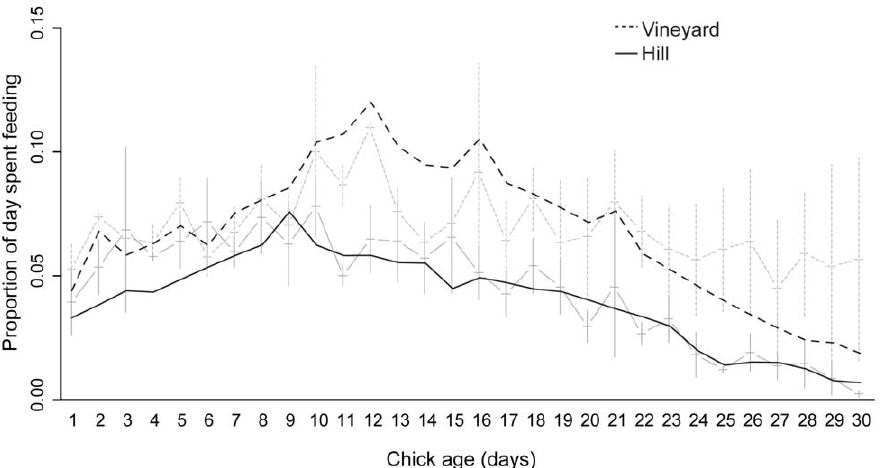
Figure 1. Proportion of the day that parents spent feeding chicks in vineyard and hill nests. Dark lines are the fitted model estimates from a GLMM with a second-order polynomial fitted for chick age. Pale lines are raw data ( + / 2 SEM). Falcons in vineyard nests spent a significantly greater proportion of the day feeding chicks compared with falcons in hill nests ( P , 0.05).